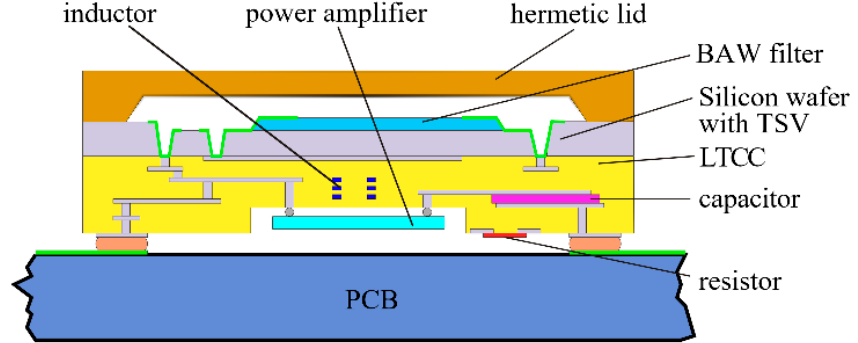
Figure 18. A hybrid integration module, including PA and BAW filter, with embedded passive components [125]. Reproduced with permission from [125].